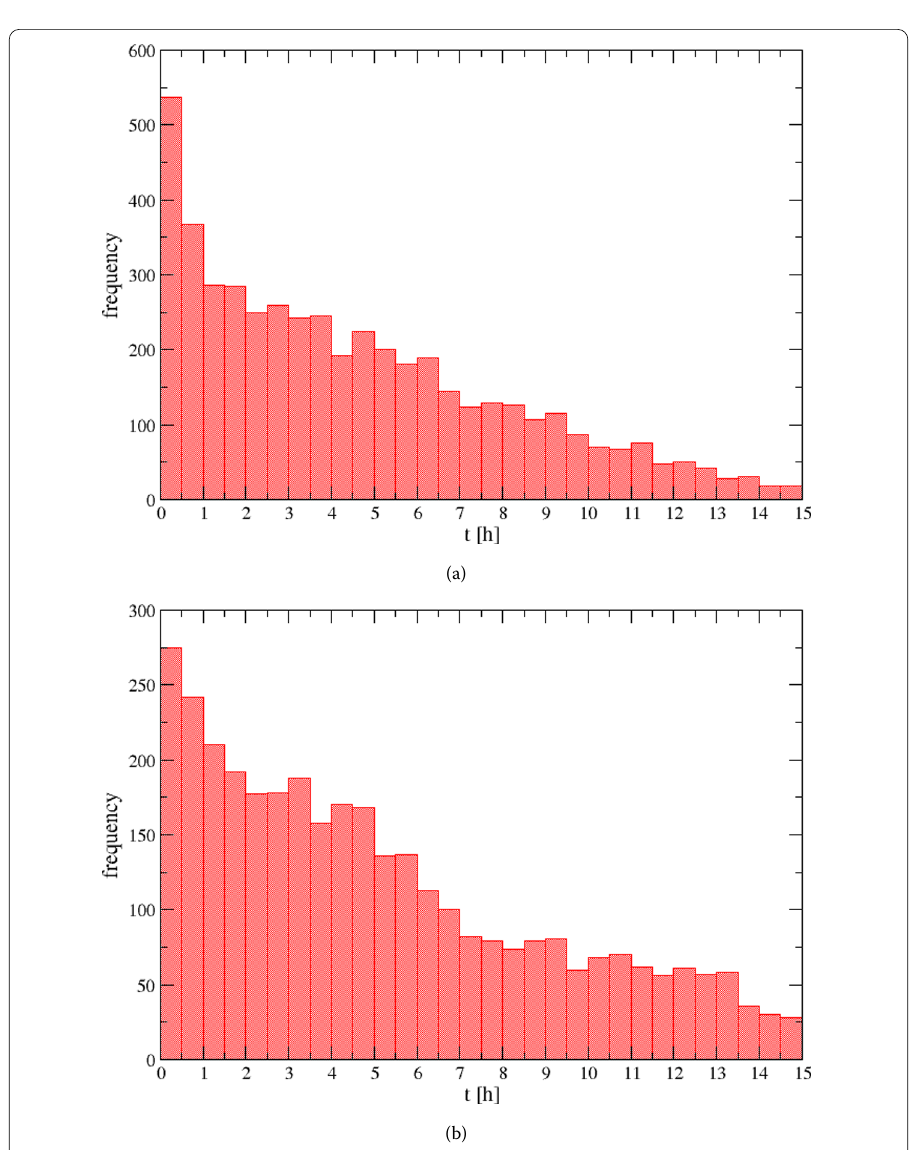
Figure 5 Distribution of the mobility time associated to the daily mobility paths reconstructed during the Carnival (left picture) and the FestadelRedentore (right picture) in the Venice historical